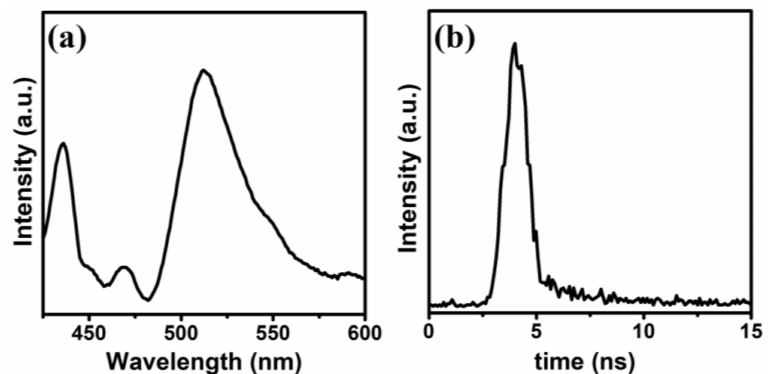
Figure 5. PL spectrum of CdS NRs ( a ), time-resolved PL spectrum ( b ).